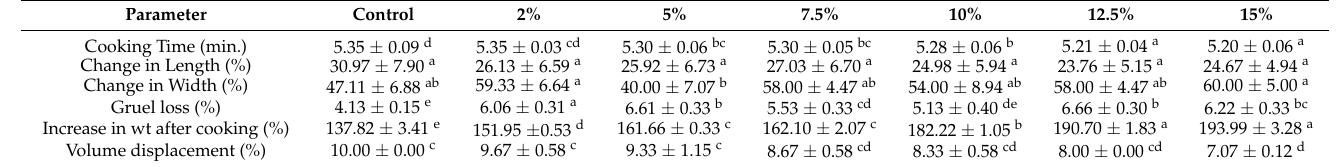
Table 5. Cooking quality of different formulations of Spirulina biomass enriched pasta.